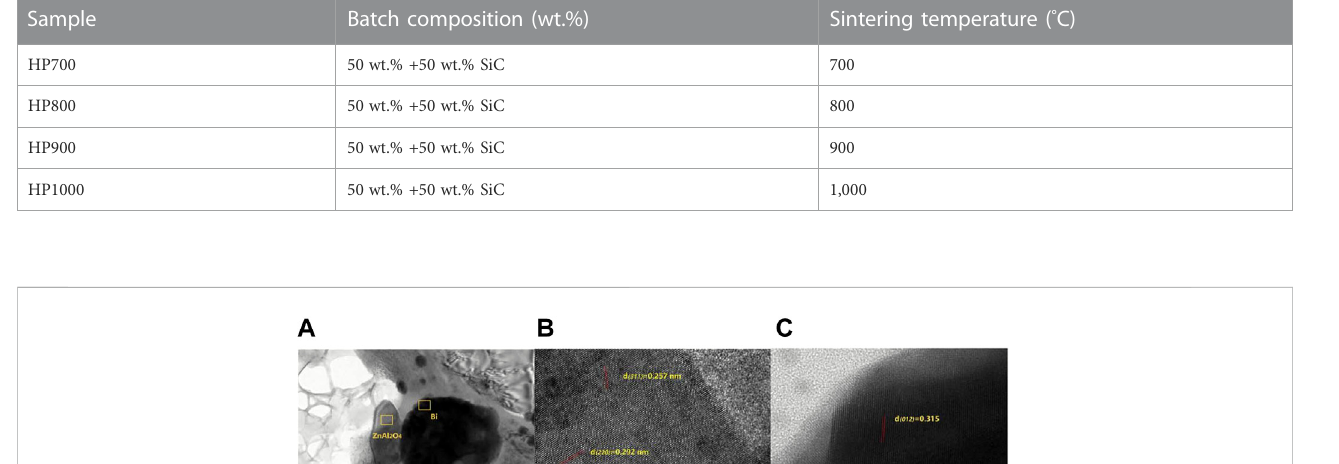
TABLE 2 Batch composition and sintering temperature of SiC/BBSZA glass composites. Sample Batch composition (wt.%)